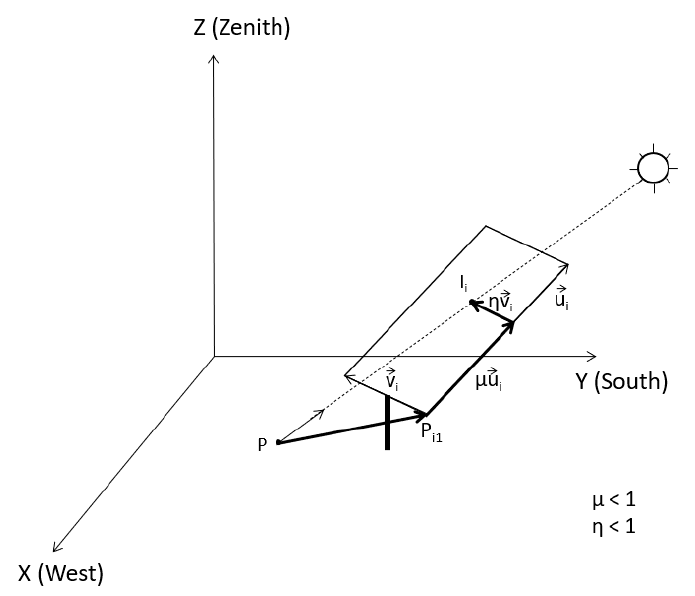
Figure 4. Geometric representation of mathematical conditions for point P to be shaded.